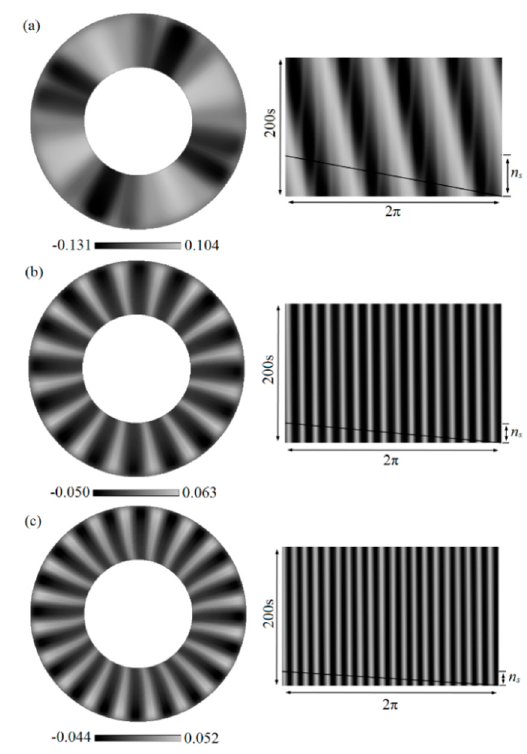
Figure 9. Snapshots of the surface concentration (left) and the corresponding STD at R = 0.55 (right) ( a ) Re s = 234, when Re T = 6.0 × 10 3 ; ( b ) Re s = 468, Re T = 6.0 × 10 3 , ( c ) Re s = 701, Re T = 6.0 × 10 3 ( d ) Re s = 468, Re T = 1.4 × 10 3 .